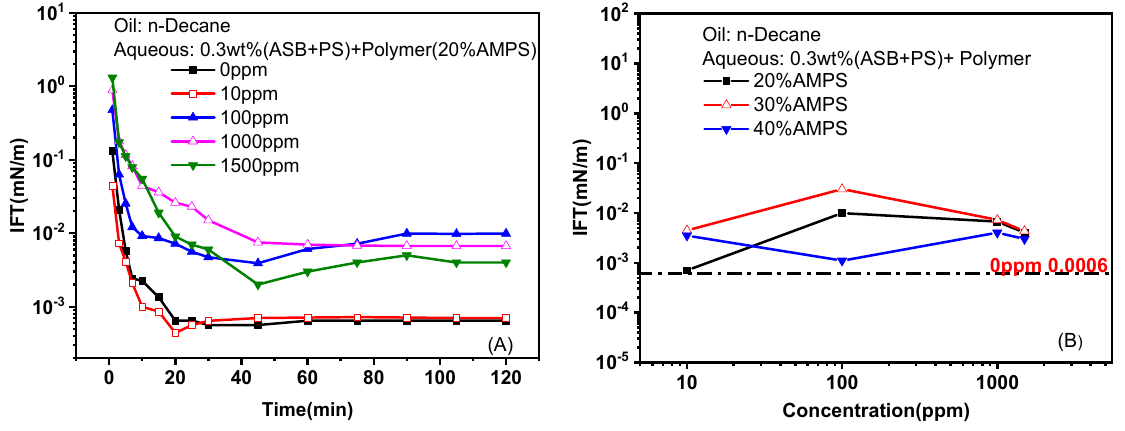
Figure 5. Effect of polymer concentration on dynamic ( A ) and equilibrium ( B ) IFTs between 0.3 wt% ASB@PS solution and n-decane.